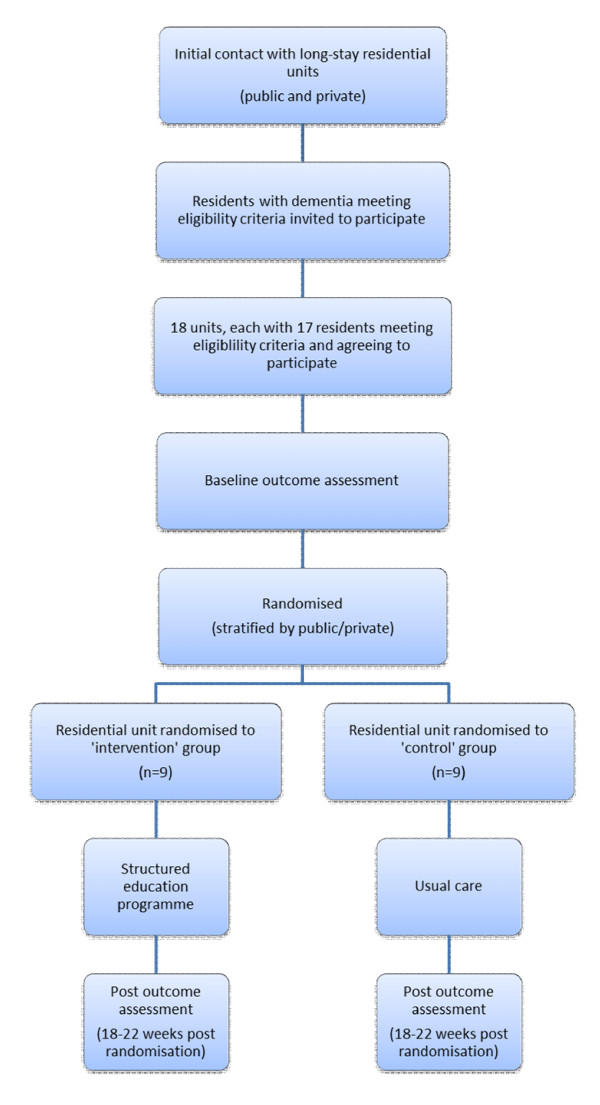
DARES Methodology.